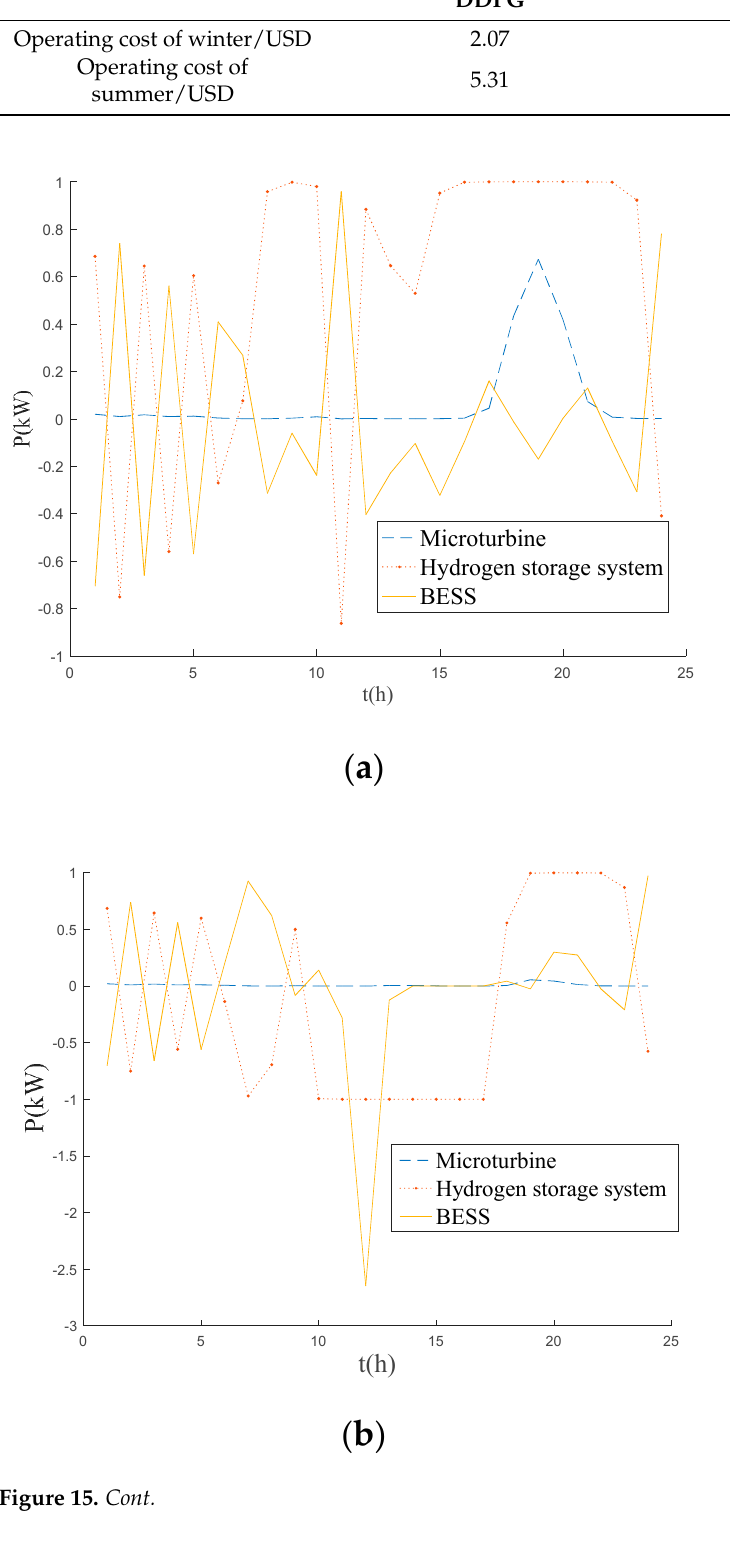
Table 5. Optimization results of different algorithms. Figure 14. PV and load forecasting curves of new microgrid scenarios. ( a ) PV and load forecasting curves in winter. ( b ) PV and load forecasting curves in summer.